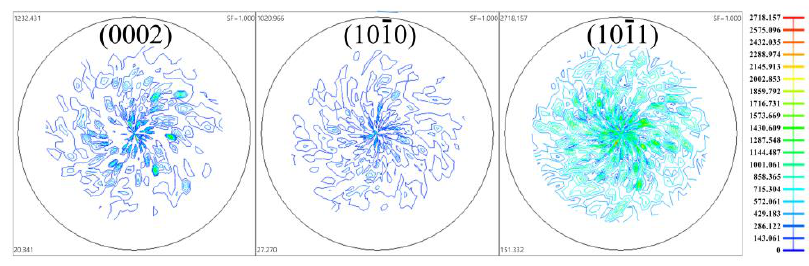
- - 0) and (101 1) pole figures of homogenized AZ31 magnesium alloy.